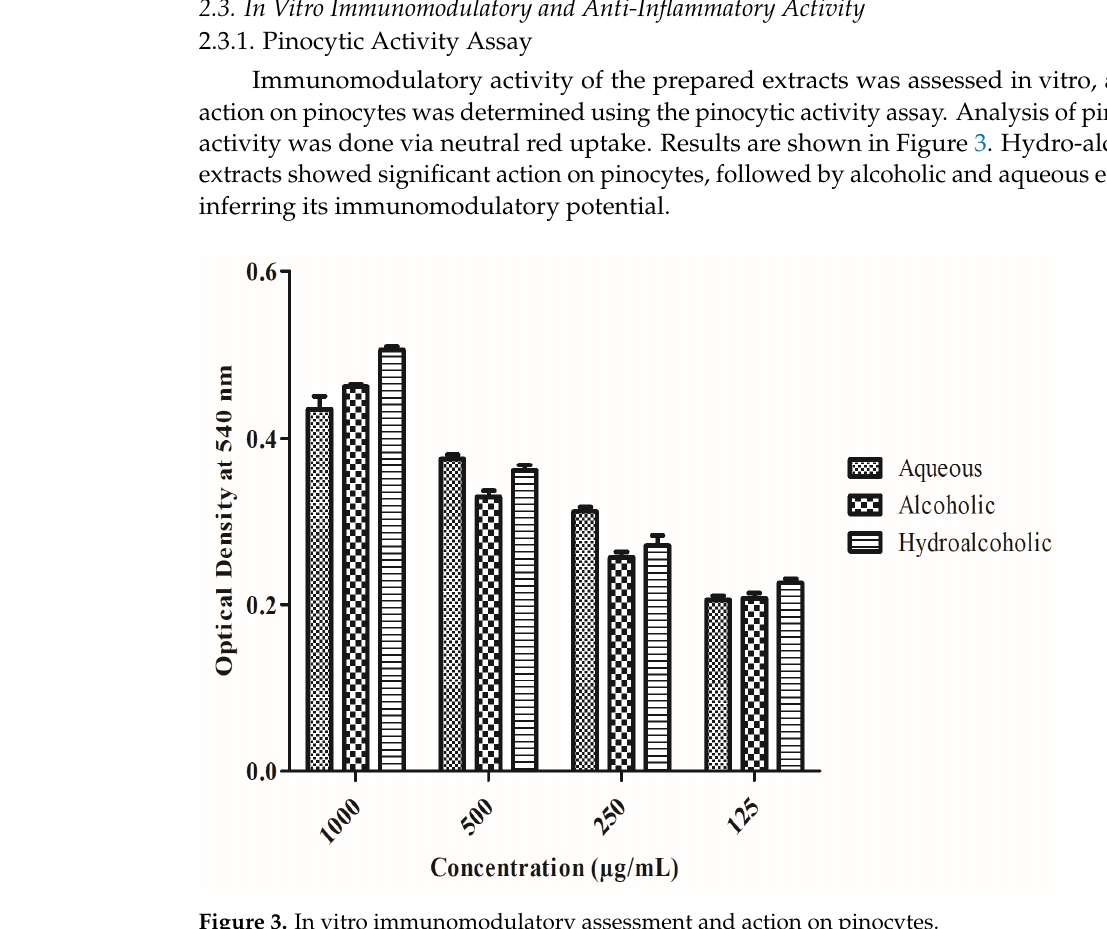
Figure 3. In vitro immunomodulatory assessment and action on pinocytes.